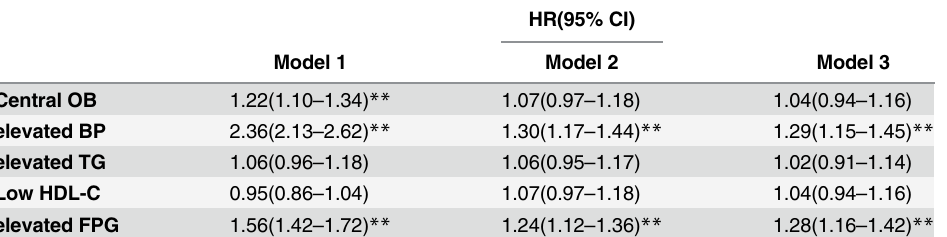
Table 7. Relationships between MS individual components and all-cause mortality after adjusted for each